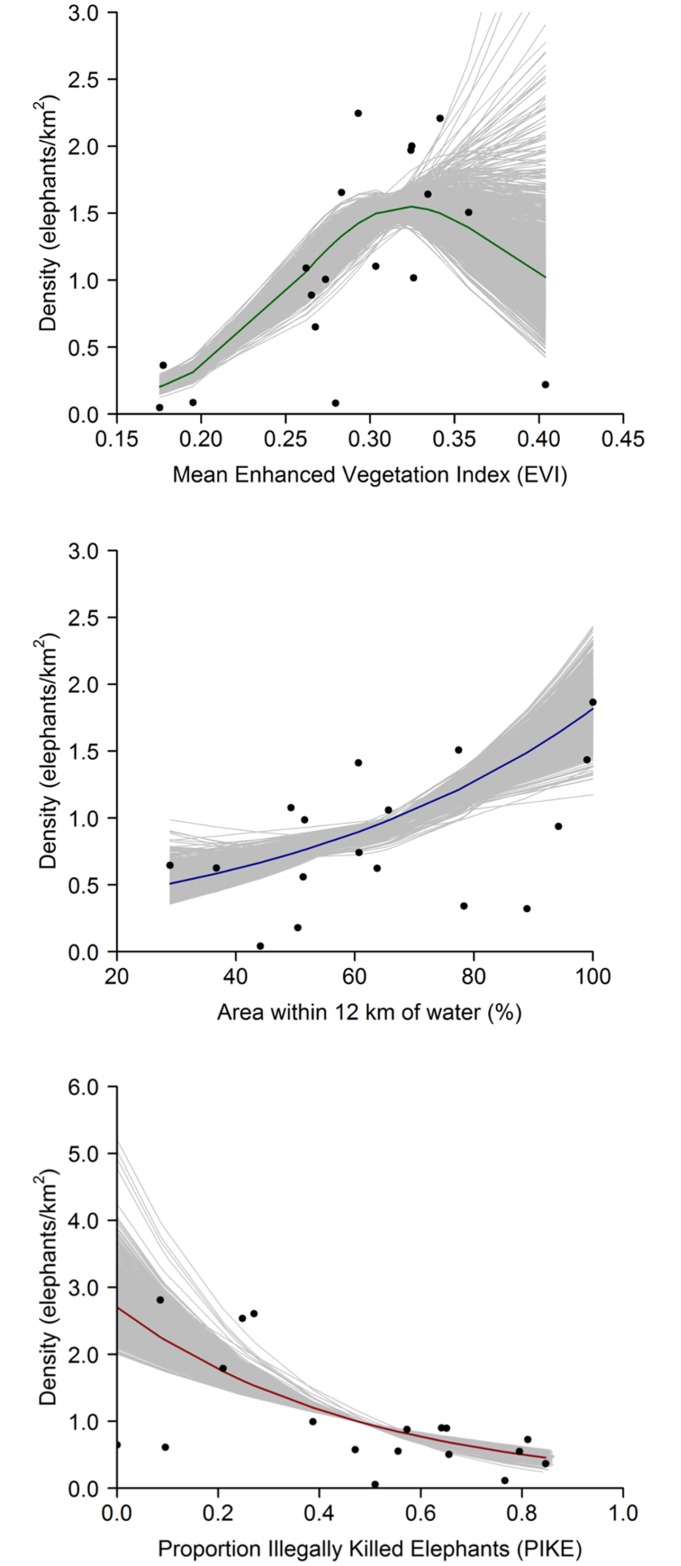
A GAM explains extracted stable densities from time series of 18 savanna elephant populations.The component smooth functions of mean EVI, percentage of protected area within 12km of water, and PIKE of the selected best GAM are represented by solid lines transformed to the response scale of density (elephants/km2). Points represent partial residuals of the 18 extracted densities, and grey lines represent 1,000 iterations to account for uncertainty.